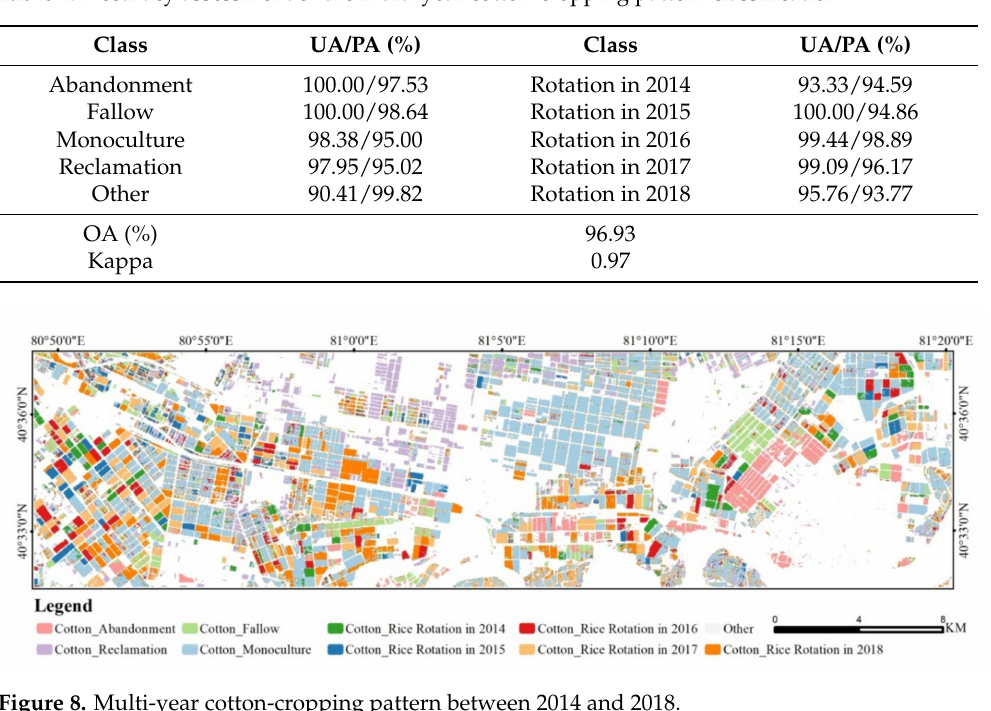
Table 4. Accuracy assessment of the multi-year cotton-cropping pattern classification.